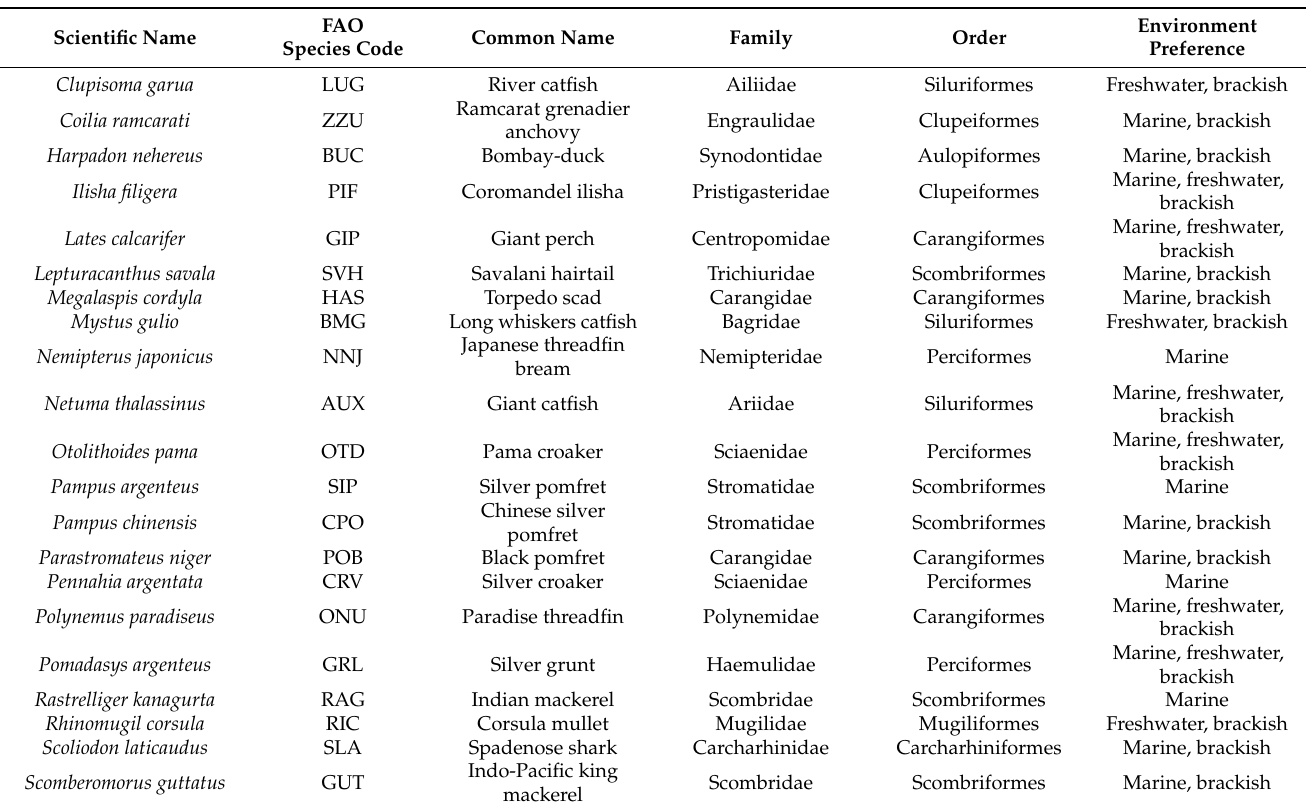
Table 1. List of bycatch species from the Hilsa gillnet fishery of Bangladesh for vulnerability assessment with